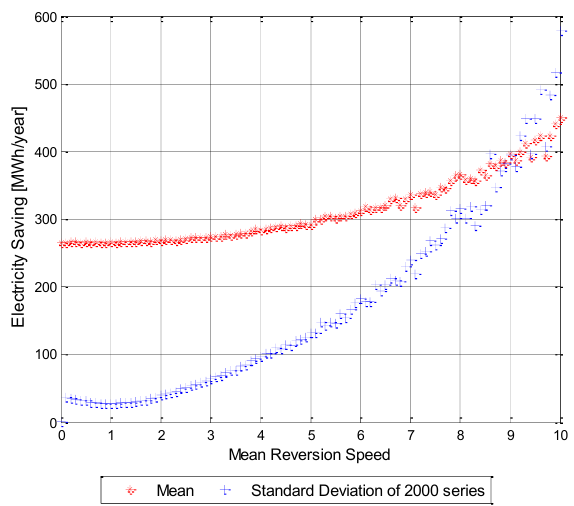
Fig. 8. Variation of mean and standard deviation of the energy saving values varying